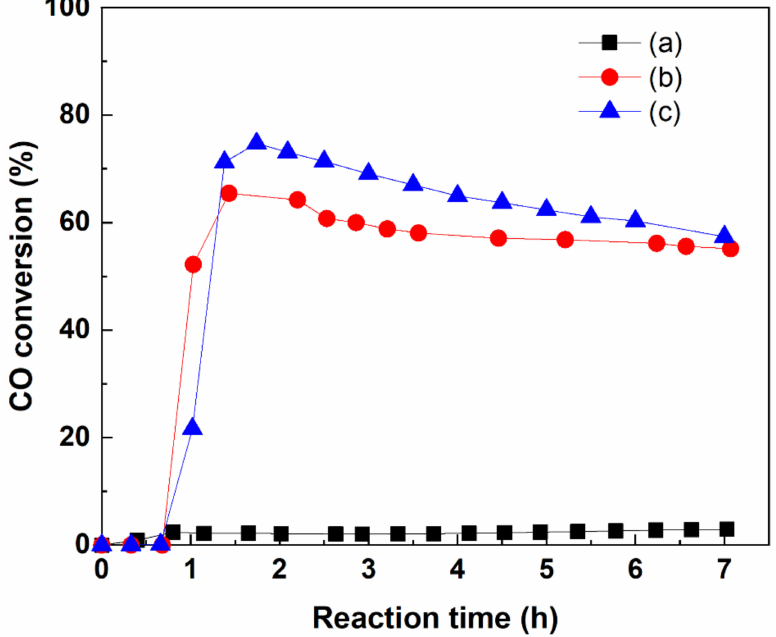
Figure 7. CO conversion over MoS 2 samples prepared at ( a ) pH 4.5; ( b ) pH 7.0; and ( c ) pH